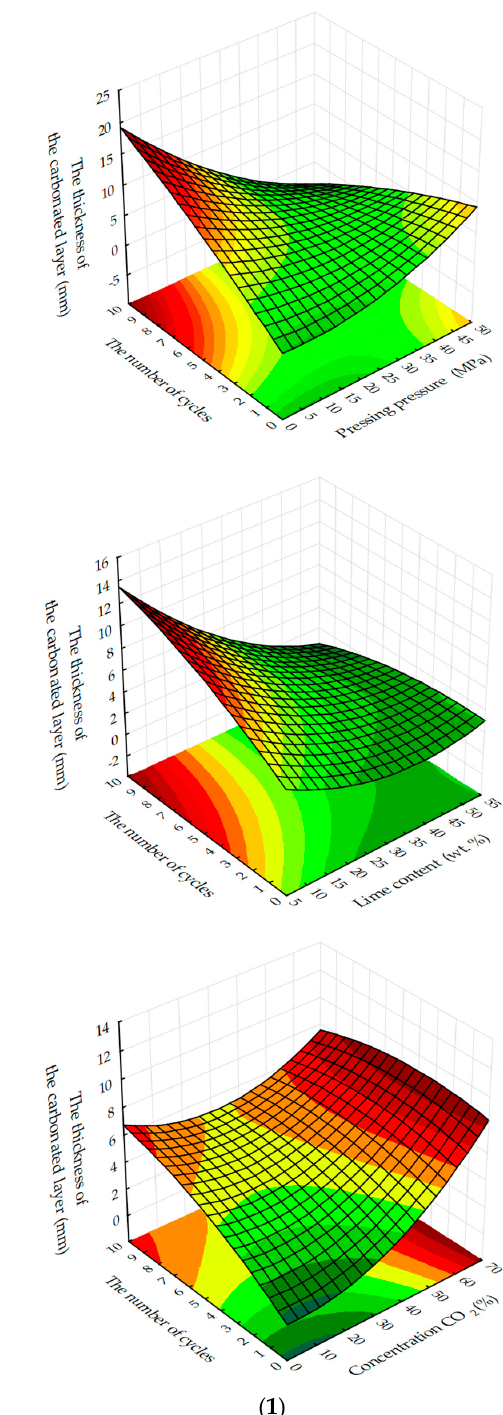
Figure 12. Response surfaces to changes in the thickness of the carbonated layer of samples carbonated by dynamic ( 1 ) and static ( 2 ) methods, depending on the number of cycles/time of carbonation and: ( a ) forming pressure of pressing; ( b ) lime dust content; ( c ) concentration of CO 2 (at zero level of variation of other factors).